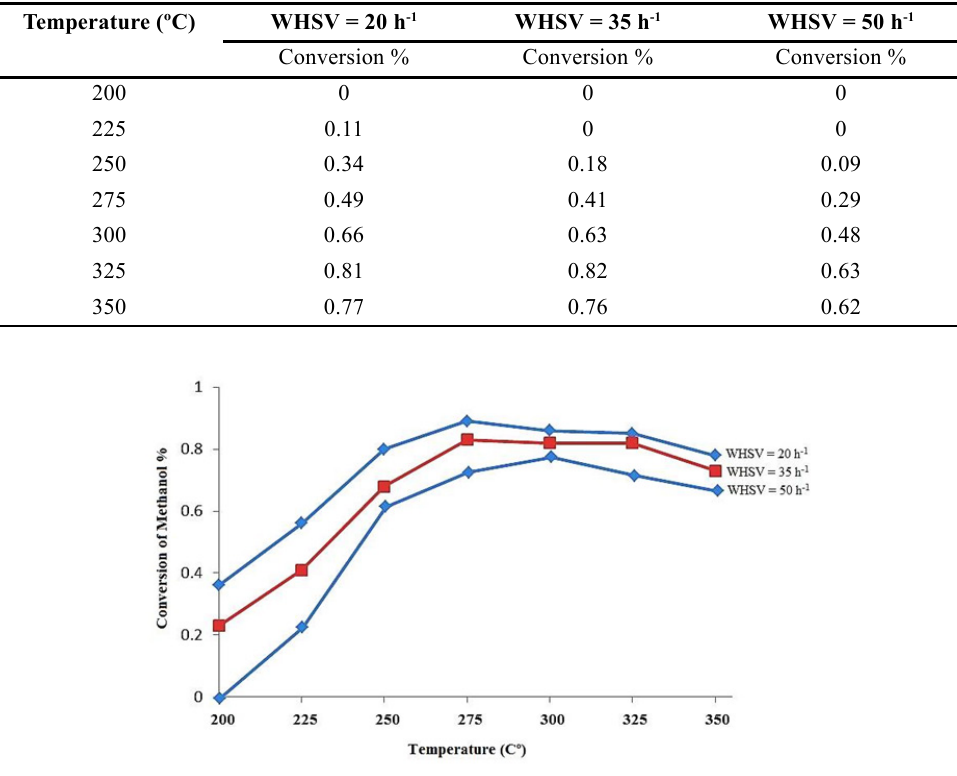
Table.3 . Experimental data for dehydration of methanol over Al-A catalyst